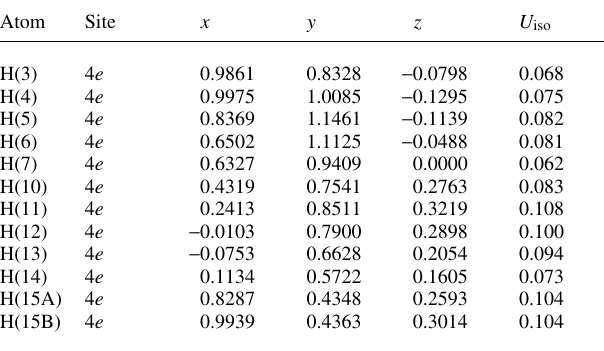
Table 2. Atomic coordinates and displacement parameters (in Å 2 )